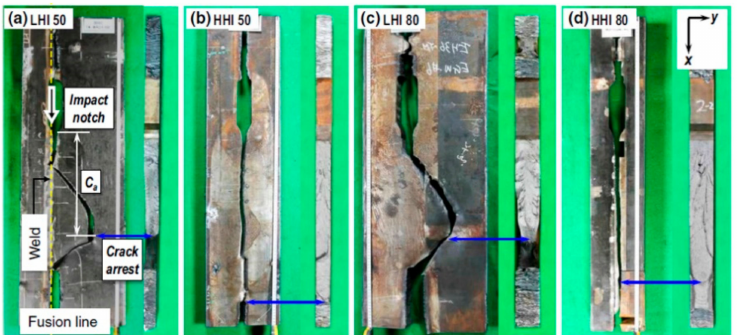
Figure 1. Brittle crack propagation path and crack arrest locations in low heat input (LHI) and high heat input (HHI) weld joints with 50 mm and 80 mm thick steel plates. ( a ) LHI weld joints of crack propagation path with 50 mm; ( b ) LHI weld joints of crack arrest position with 50 mm; ( c ) HHI weld joints of crack propagation path with 80 mm; ( d ) HHI weld joints of crack arrest position with 80